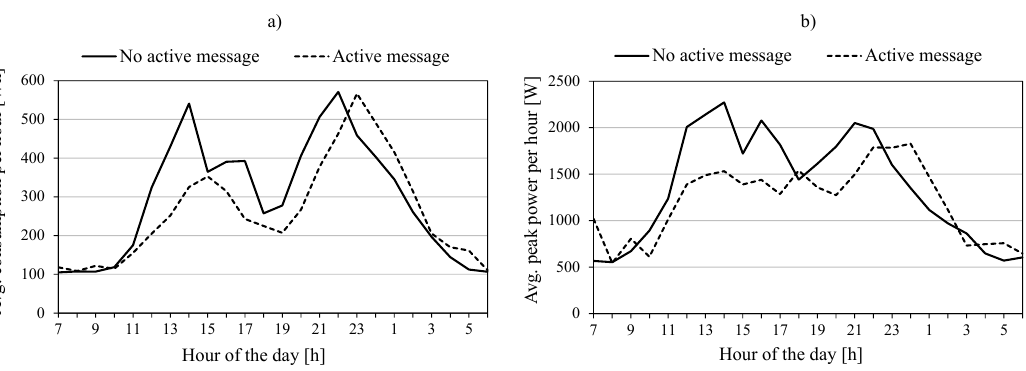
Figure 10. Comparison of the average power demand in times of no active call for action and in times of active CtAs to maintain different power limits. ( a ) Comparison of the average power consumption per hour, ( b ) Comparison of the average peak power per